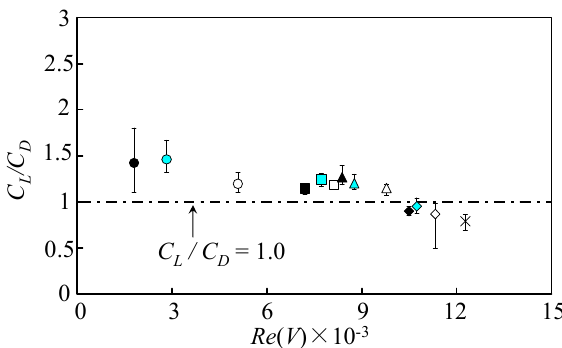
Fig. 19 Lift-to-drag ratio C L /C D versus Reynolds number Re ( V ) based on a theoretical descent velocity V , for several values of inertia-moment ratio I * at depth-to-width ratio λ = 0.3, aspect ratio AR = 10, C = 3.86 × 10 2